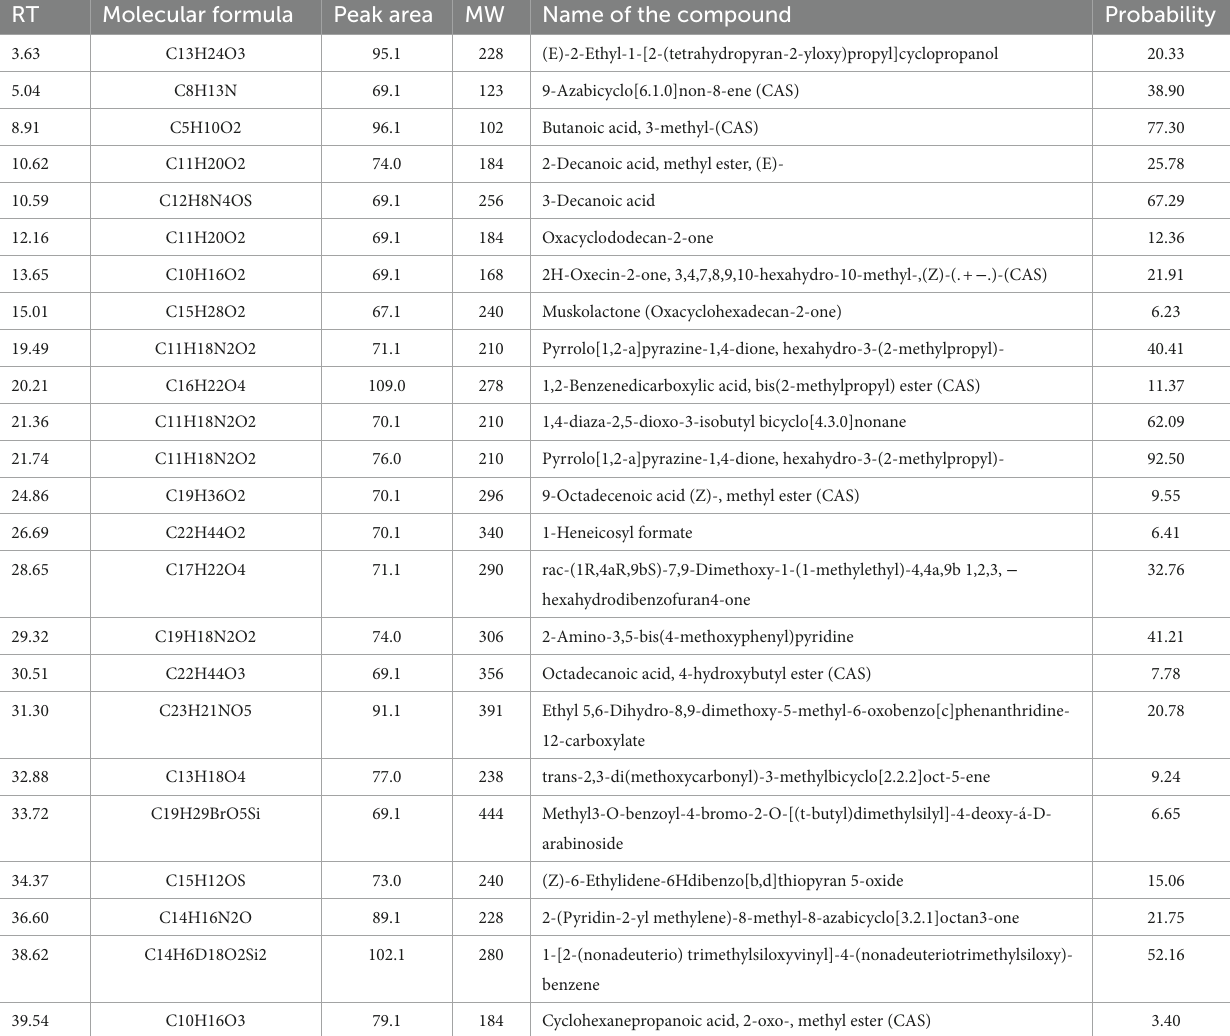
TABLE 2 GC–MS analysis of secondary metabolites of Pseudomonas fluorescens (TPf 12). RT Molecular